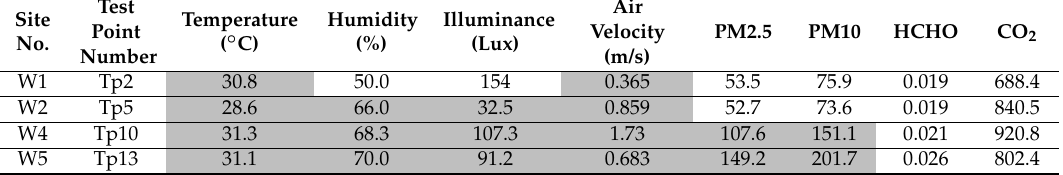
Table 7. Average values for the physical test results from the tube entrance (connection to subway). Site No.